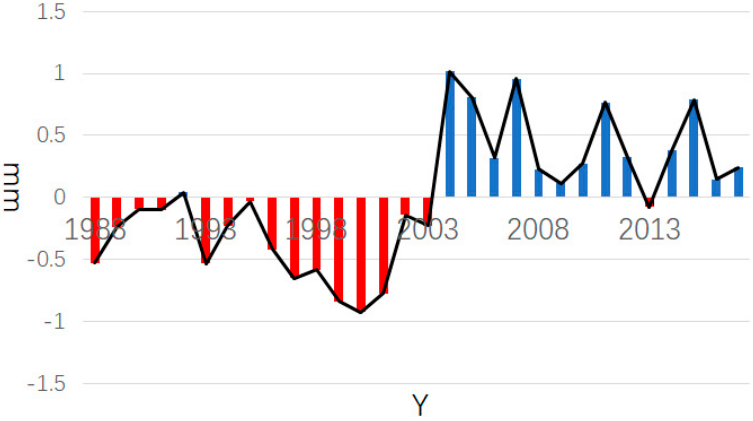
Figure 1. Winter precipitation anomalies in the Barents and Kara Seas from 1988 to 2017, unit: mm.